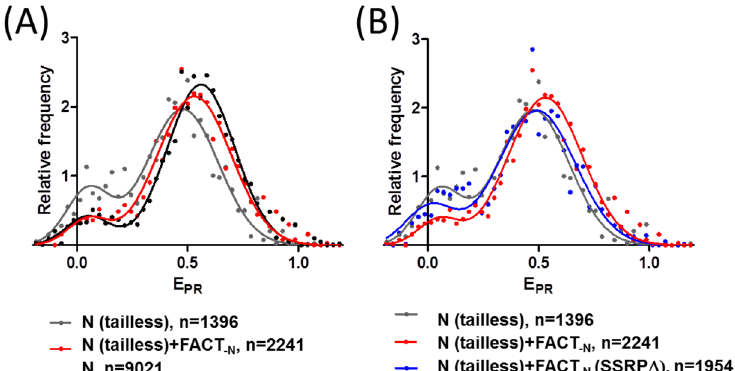
Figure 4. FACT stabilizes tailless nucleosomes. CTD and/or HMG domain(s) of SSRP1 are required for this activity. Effect of FACT -N ( A ) and comparison of the effects of FACT -N and FACT -N (SSRP ∆ ) on tailless nucleosomes ( B ) as detected by spFRET microscopy. Typical frequency distributions of proximity ratios (E PR ) are shown. n is a number of analyzed nucleosomes.